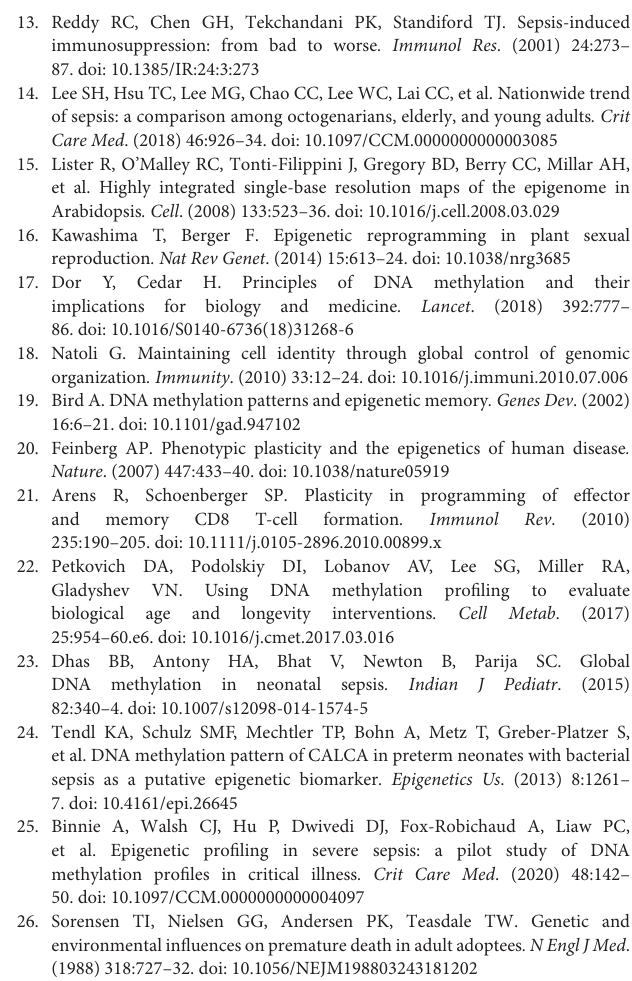
Supplementary Figure 1 | (A) Quantitative PCR analysis of spleen IL-6, IL-1 β , TNF- α at different time after CLP shows the expression of these factors reached the highest peak 6h after CLP. (B) The mice were sacrificed at different time after CLP and lung tissue was stained with haematoxylin-eosin (magnification, × 400). (C) The lung injury score. n = 5. Data were shown in Mean ± SD. ∗∗∗∗ p < 0.0001,